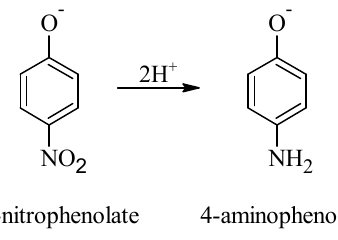
Table 1. Data of nitrate concentration as function of degradation time, obtained through ion chromatography